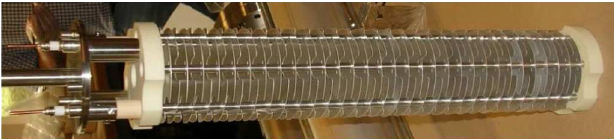
FIG. 17. (Color) Interior part of an ionization chamber used as a beam-loss monitor in the LHC. Taken from Ref. [43].